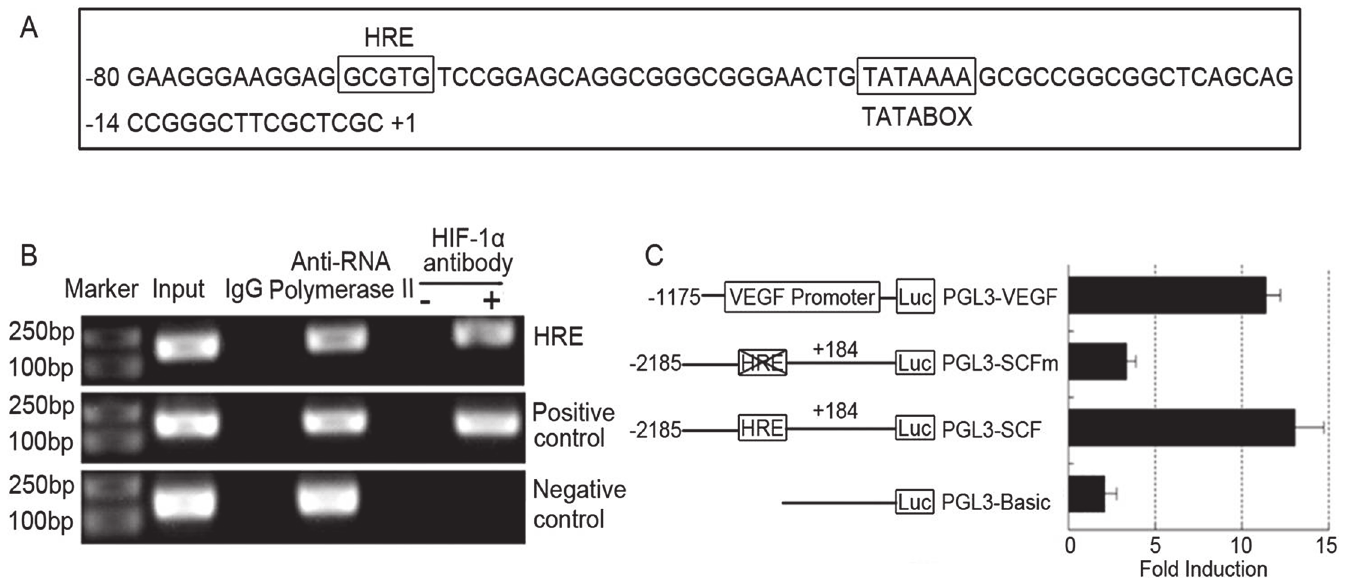
Fig 3. HIF-1 α directly binds to the HRE region of SCF promoter and up-regulates the activity. (A): The DNA sequence of the SCF promoter. A potential HIF-1 α binding site is located at − 68 to − 64 near the start site of transcription. (B): Chromatin immunoprecipitation analysis. PANC-1 cells were cultured under normoxia and hypoxia for 12 h and then analyzed. The PCR products of SCF promoter were only detected in the samples that were precipitated by HIF-1 α antibodies but not in control IgG samples. The SCF promoter region (-1163 to-955) that do not contain HRE (non-HRE) cannot be precipitated by HIF- 1 α antibodies. (C): Dual luciferase results in different groups. After transfected with pcDNA3.1-HIF-1 α plasmids (1 μ g) with pGL3-SCF (1 μ g) or (pGL3-SCF-M) (1 μ g), pGL3-VEGF was used as the positive control. After transfection incubation for 48 h and incubated under hypoxia for 12 hrs, the cells were harvested for dual luciferase assay. The results showed that the full-length SCF promoter activity (pGL3-SCF) was increased for 12.8 fold after over expression of HIF-1 α compared to that treated with plasmids alone, but the mutation of SCF promoters (pGL3-SCF-M) did not increase. Over-expression of HIF-1 α was increased for 11.6 fold of the VEGF promoter activity compared to the controls.